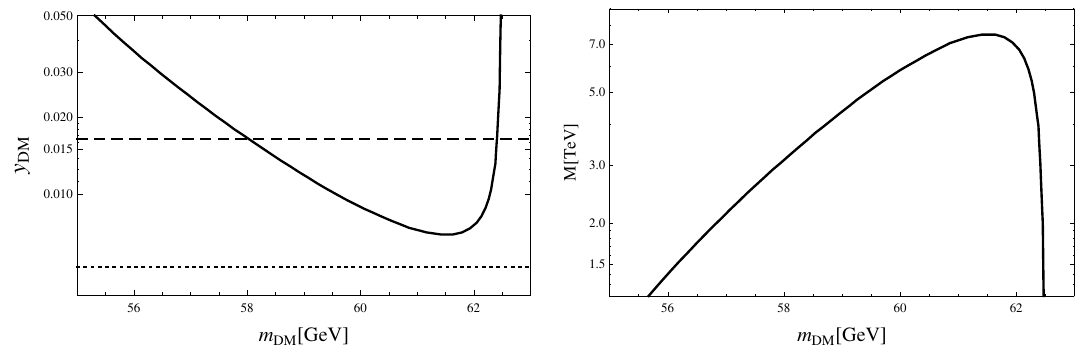
Figure 2 . Left panel: y DM as a function of m DM (solid line) along which the observed DM density Ω DM h 2 = 0 . 1198 is reproduced. Here, the current experimental upper bound from the LUX 2016 result [33] and the prospective reach in the future LUX-ZEPLIN DM experiment [34] are also shown as the dashed and the dotted lines, respectively. Right panel: M as a function of m DM , along the solid line in the left